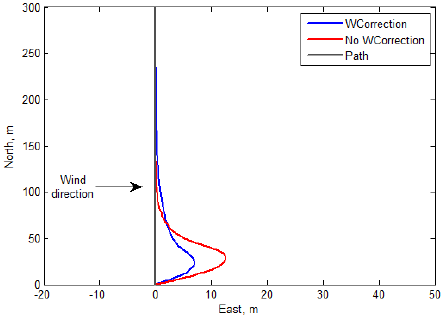
Figure 7: Airplane response in presence of wind